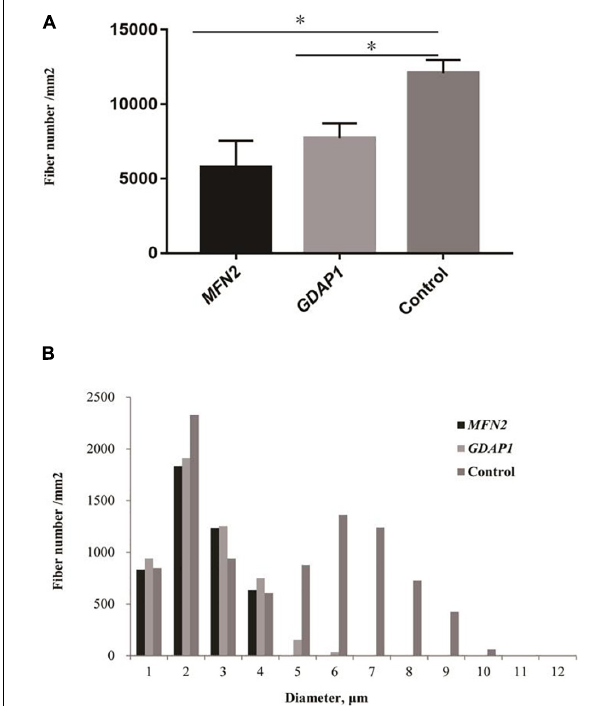
FIGURE 1 | Quantitative analysis of sural biopsy specimens. (A) The myelinated fiber density of patients with Charcot–Marie–Tooth disease (CMT)2A and CMT2K compared with age- and sex-matched controls. (B) Histogram showing the unimodal distribution pattern of myelinated fibers with loss of large myelinated fibers and low fiber density in patients compared with age- and sex-matched controls. ∗ p <